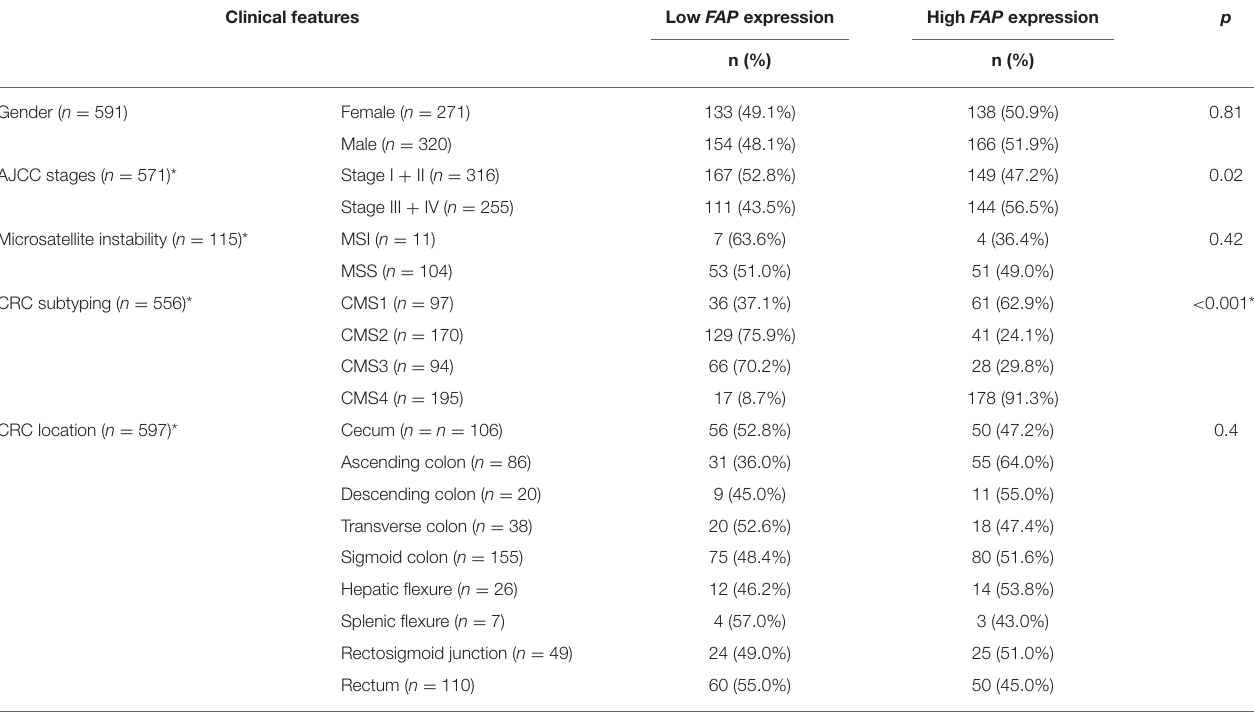
TABLE 2 | Association between FAP mRNA expression and clinicopathological features in the TCGA cohort. Clinical features Low FAP expression High FAP